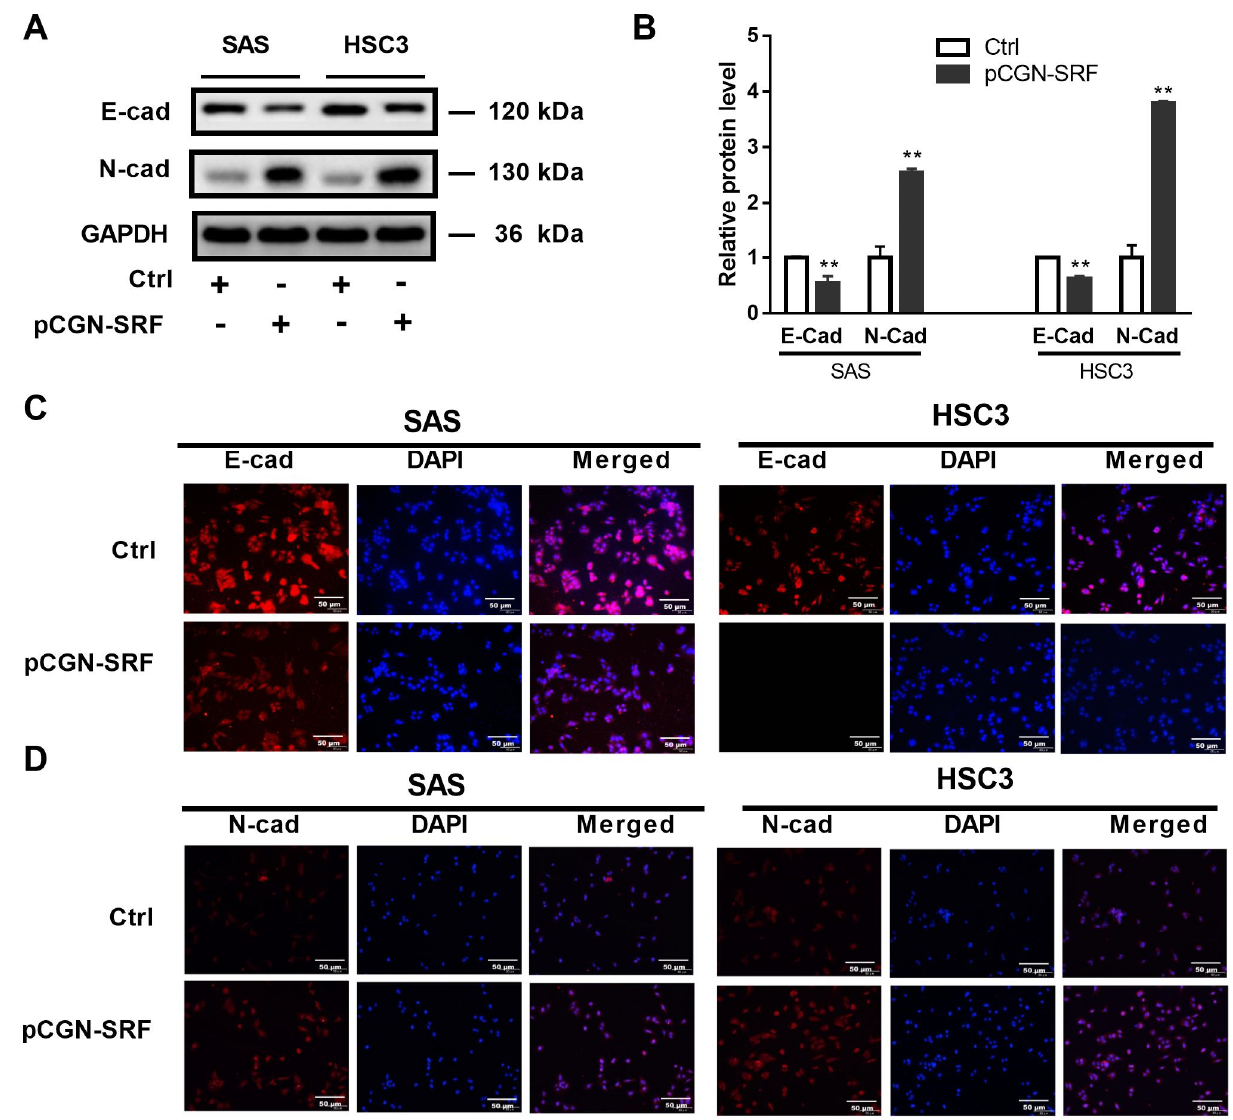
Figure 3. Serum response factor promotes OSCC cell epithelial-to-mesenchymal transition. Serum- starved OSCC cells (SAS and HSC3) were transfected with pCGN-SRF or Ctrl vectors. At 72 h post-transfection, the protein levels of E-cadherin and N-cadherin were detected via western blotting. GAPDH served as a protein loading control ( A ). Original western blots are shown in Figure S6. The relative band intensity was determined through densitometric analysis ( B ). Data are presented as the mean ± SD of three independent experiments. ** p < 0.01 vs. control vector. ( C ) Immunofluo- rescence staining of E-cadherin in SAS and HSC3 cells transfected with pCGN-SRF or Ctrl vectors. ( D ) Immunofluorescence staining of N-cadherin in SAS and HSC3 cells transfected with pCGN-SRF or control (Ctrl) vector. Scale bar: 50 µ m. Data are representative of three independent experiments. Ctrl, control; E-cad, E-cadherin; N-cad, N-cadherin; OSCC, oral squamous cell